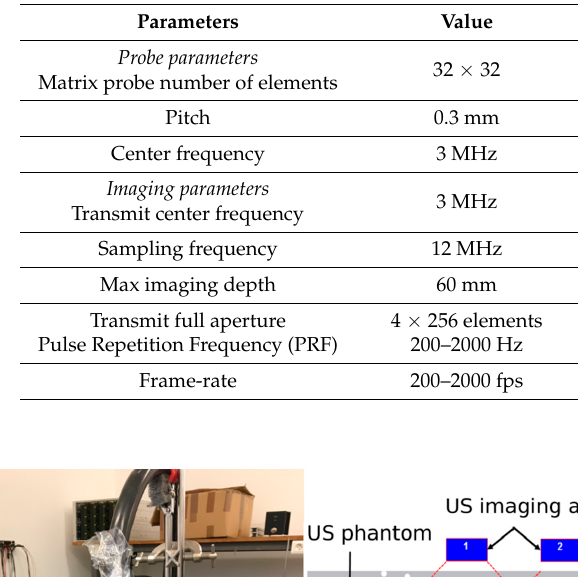
Table 1. US acquisition parameters.